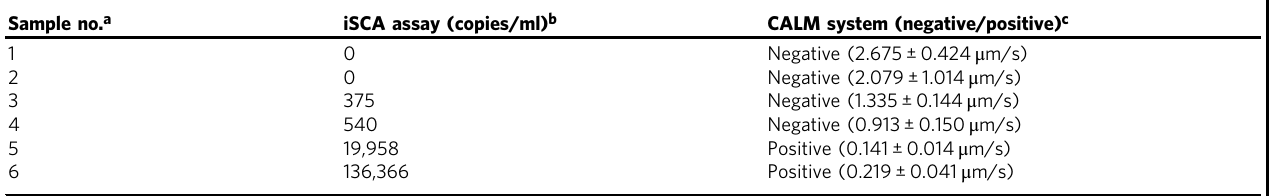
Table 2 CALM system evaluation using HIV-infected patient serum samples Sample no.